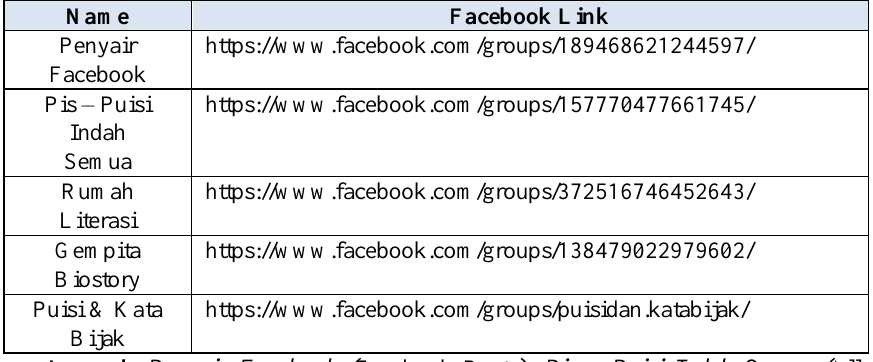
Table 3. Facebook Groups for Cyber